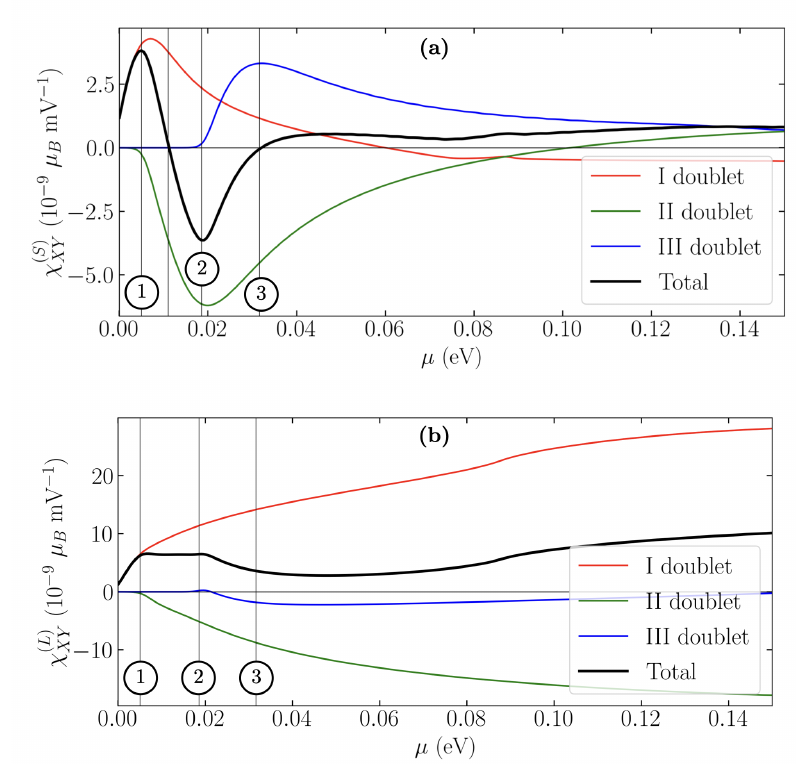
Figure 3. Spin ( a ) and orbital ( b ) Edelstein coefficient as a function of the chemical potential. The dif- ferent colours correspond to the contribution of a specific Kramers